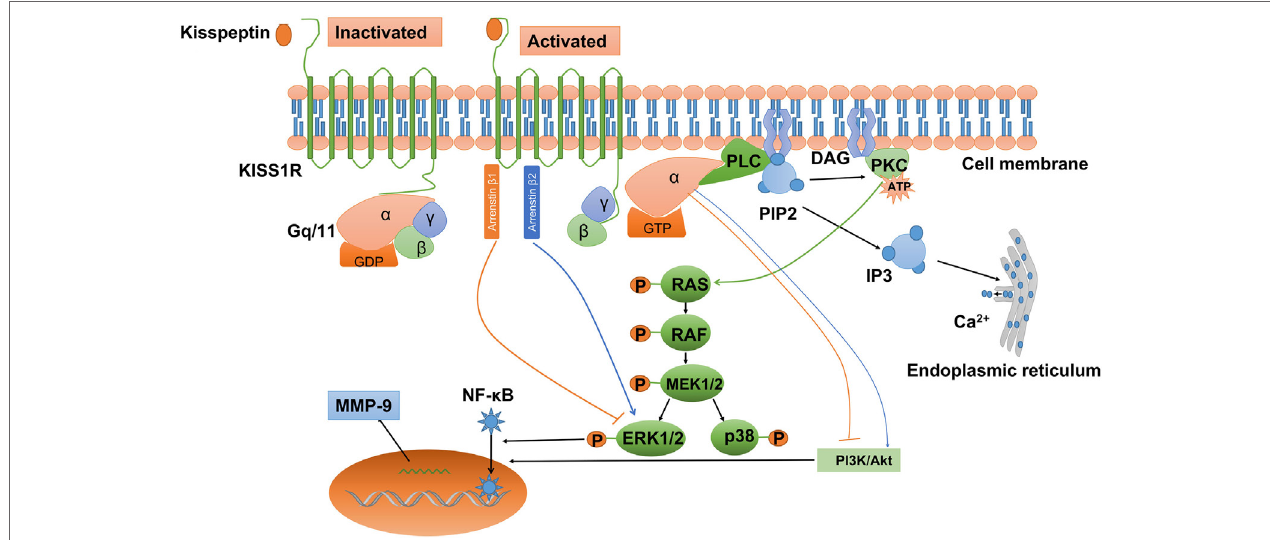
FigURe 2 | Kisspeptin/kisspeptin receptor (KISS1R) signaling at a glance. KISS1R is a seven-transmembrane domain, Gq/11-coupled receptor. Upon binding of kisspeptin, the intracellular portion of KISS1R phosphorylates Gq/11. The α -subunit of Gq/11 activates PLC, which cleaves PIP2 into IP3 and DAG. IP3 promotes intracellular Ca 2 + release from the endoplasmic reticulum, while DAG activates a signaling cascade by phosphorylating PKC. PKC activation induces the phosphorylation of MAP kinases, such as ERK1/2 and p38. In addition, activation of KISS1R recruits arrestin-1 and -2, which downregulated and upregulated phosphorylated ERK1/2 levels, respectively. The activation of KISS1R can stimulate or inhibit the phosphorylation of PI3K/Akt, depending on the cell types, but the intermediator is not investigated. Activated KISS1R also enhances the expression of MMP-9 via PI3K/Akt/NF- κ B or ERK/NF- κ B signaling. DAG, diacylglycerol; ERK1/2, extracellular signal-regulated kinase; IP3, inositol 1,4,5-triphosphate; PI3K, phosphatidylinositol-3-kinase; MMP-9, matrix metalloproteinase-9; NF- κ B, nuclear factor κ B; PIP2, phosphatidylinositol 4,5-bisphosphate; PKC, protein kinase C; PLC, phospholipase